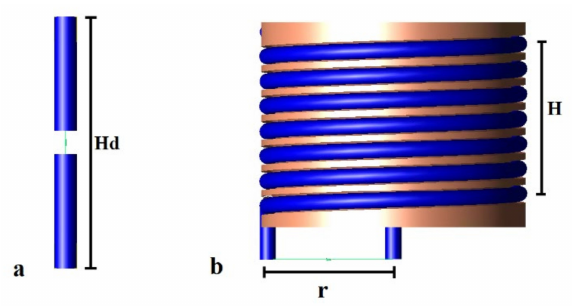
Figure 2. Transmitting antenna ( a ) half-wave dipole Hd = 22 mm, ( b ) helical antenna model: H = 5.6 mm, r = 4 mm